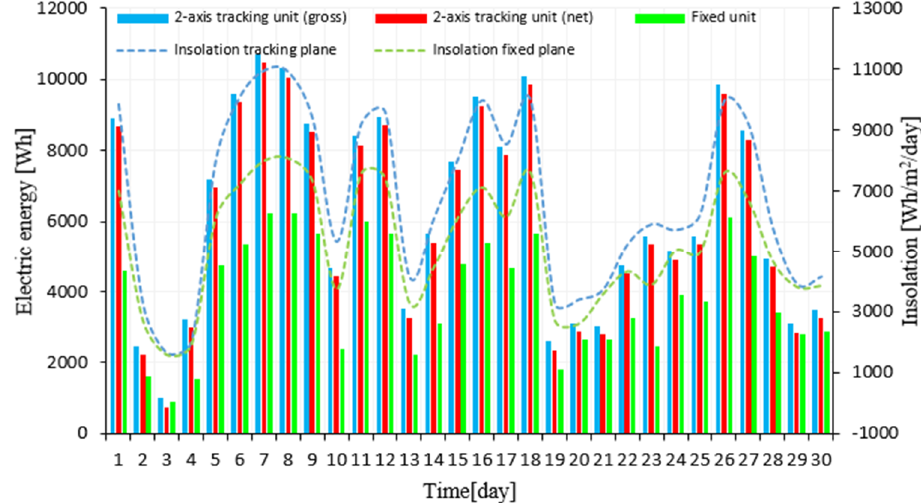
Figure 16. Variability of the electricity production and the determined insolation for photovoltaic modules in the fixed and dual-axis tracking configurations in June 2017.